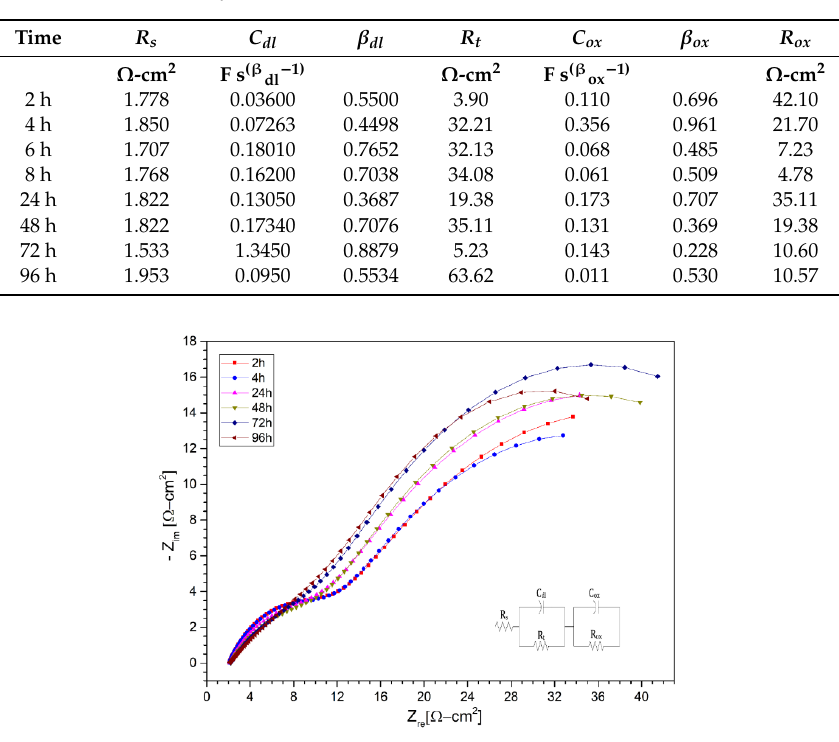
Table 6. Fitting results of the impedance spectra of stainless steel AISI 304 during corrosion in the presence of LiNaKNO 3 (ternary salt with lithium content) at 550 ◦ C.